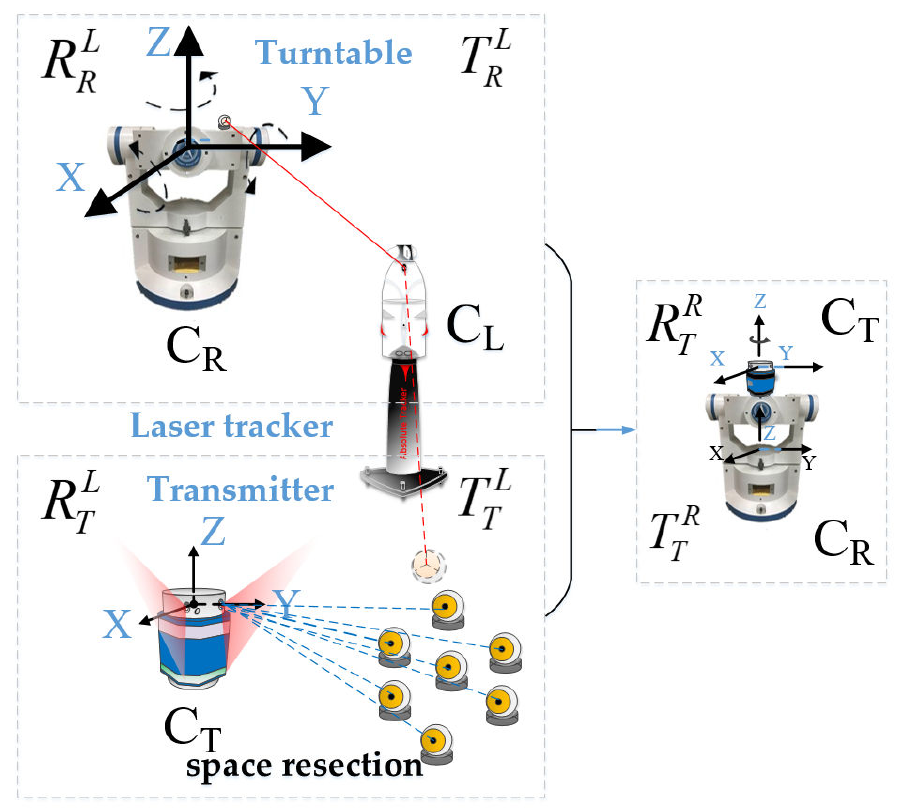
Figure 2. The spatial calibration between the transmitter and the